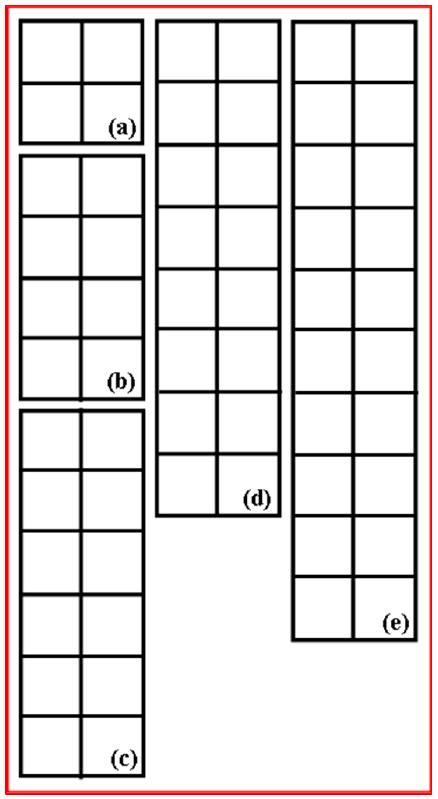
Figure 4. A set of antennas with different antenna lengths in which the diameter of wire was 3.0 mm and the area of the gap was 24 × 24 cm 2 . The width was 72 cm, and the lengths were ( a ) 48 cm, ( b ) 96 cm, ( c ) 144 cm, ( d ) 192 cm, and ( e ) 240 cm.